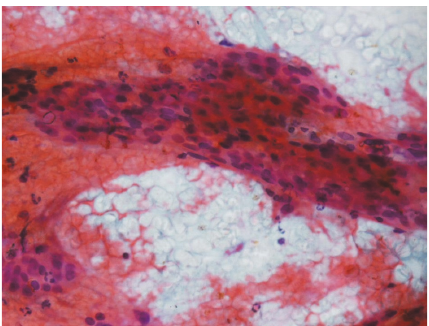
Figure 4: FNA biopsy also demonstrates presence of atypical cells as clusters, highly suggestive for malignancy (Case